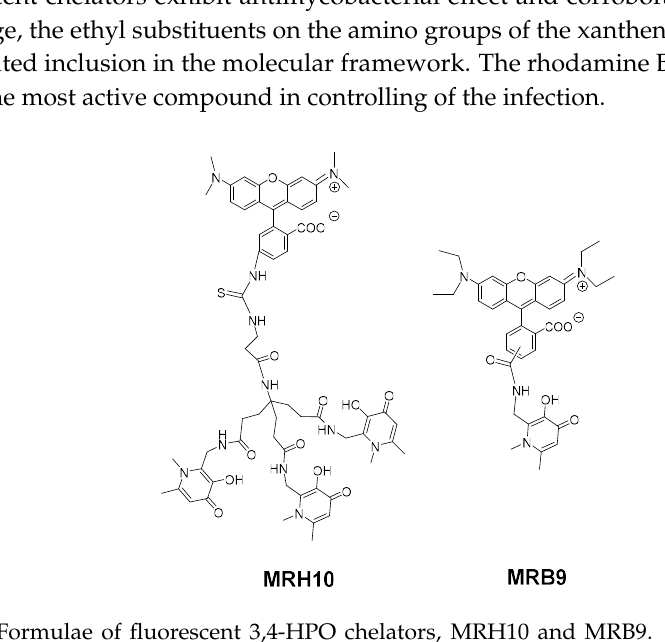
Figure 6. Formulae of fluorescent 3,4-HPO chelators, MRH10 and MRB9. The abbreviation and numbering of compounds was assigned according to chelator denticity (MRB i for bidentate and MRH i for hexadentate) and fluorophore ( i = 9–10).